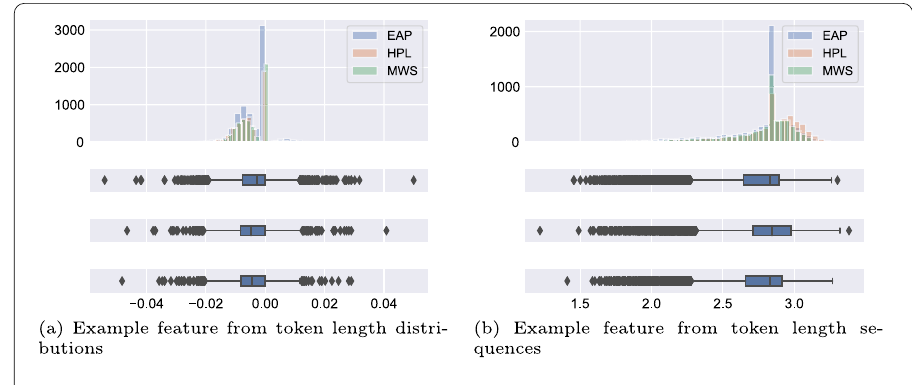
Figure 20 Exploratory analysis of features with non-trivial distributions. ( a ) Log-transformed feature TLD__change_quantiles__f_agg_“mean”__isabs_False__qh_0.6__ql_0.2 extracted from token